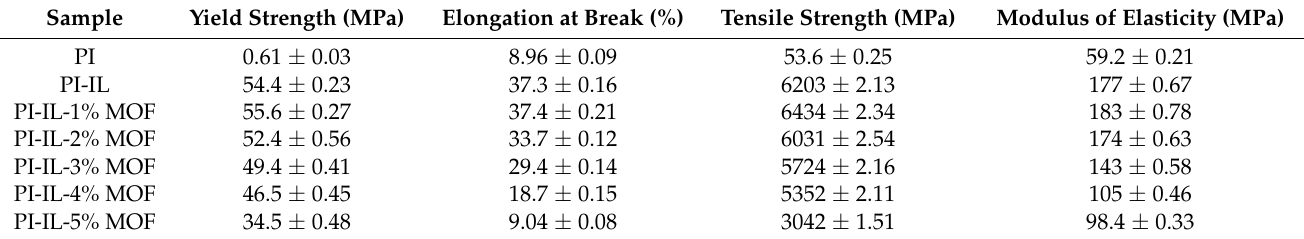
Table 2. Mechanical properties of PI-IL/x%MOF membranes a .